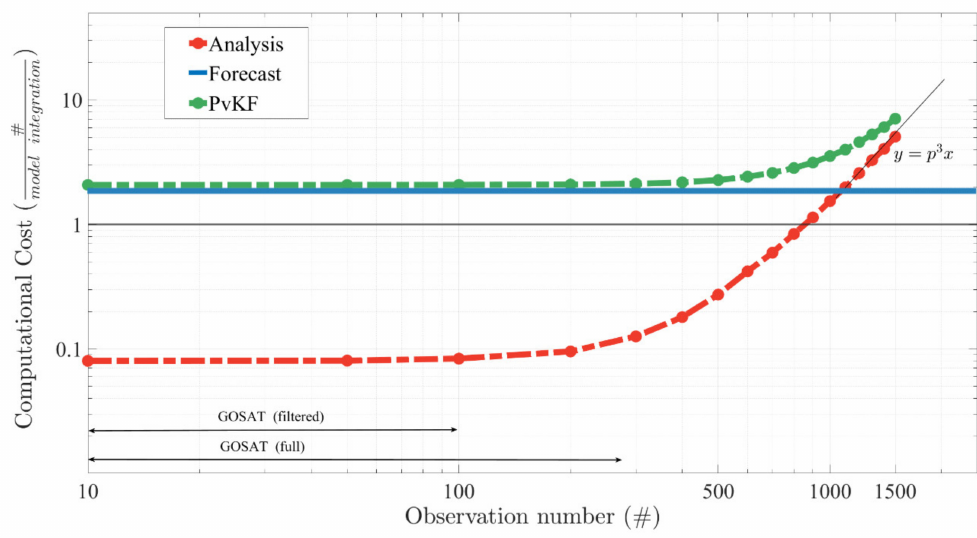
Figure 10. 1-h computational time of the analysis (dashed red line) with respect to the number of observations within the PvKF assimilation. The solid black line shows the computational time of a 1-h H-CMAQ simulation with a known computational configuration. The solid blue line denotes the forecast step of PvKF that includes two forecasts, one for the methane transport and the other for the advection of error variance. The dashed green line represents the total computational time expected for the